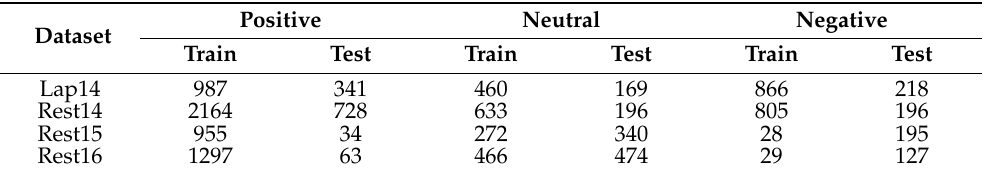
Table 2. Statistics of the datasets on SemEval.